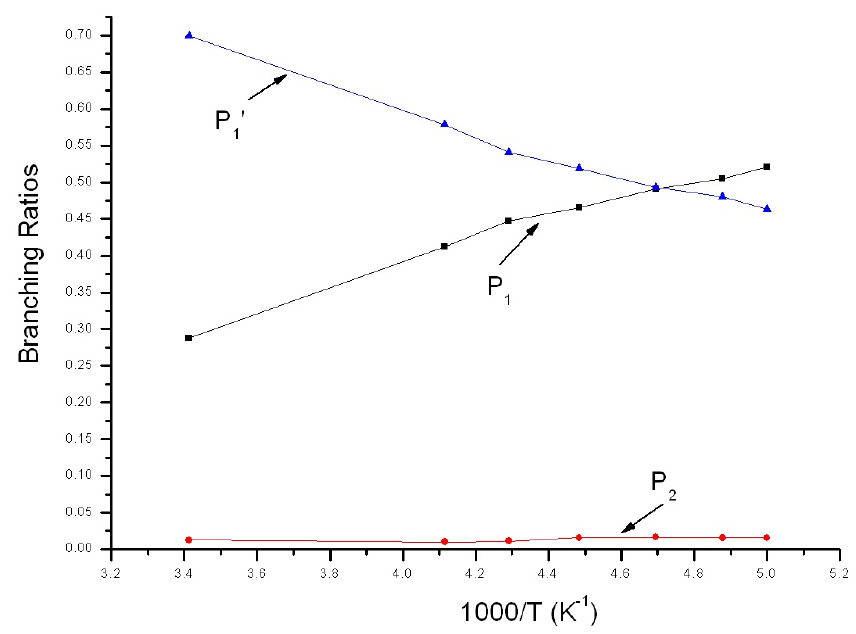
Figure 5. Branching ratios of various reaction channels at 1 Torr in a temperature range from 200 K to 293 K.